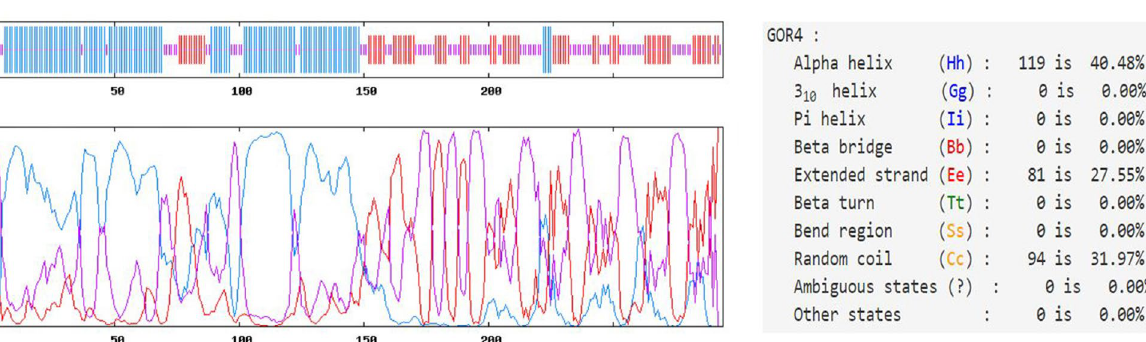
Figure 2. The structural arrangement of the final multi-epitope vaccine construct.